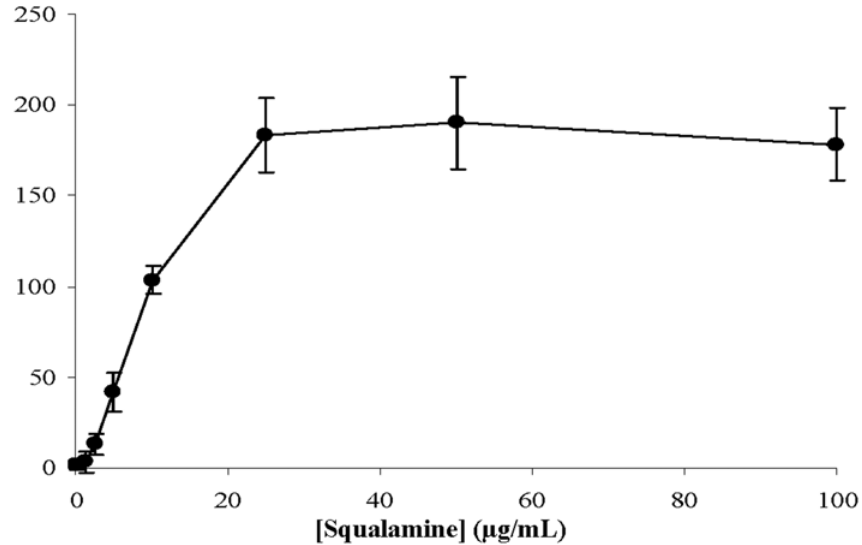
Figure 4. Effect of squalamine on bacterial membrane integrity assessed by fluorescence measurement of propidium iodide – DNA/ RNA interactions. Results are expressed in relative fluorescence unit (RFU) as Mean 6 S.D. (n=3, three independent experiments).